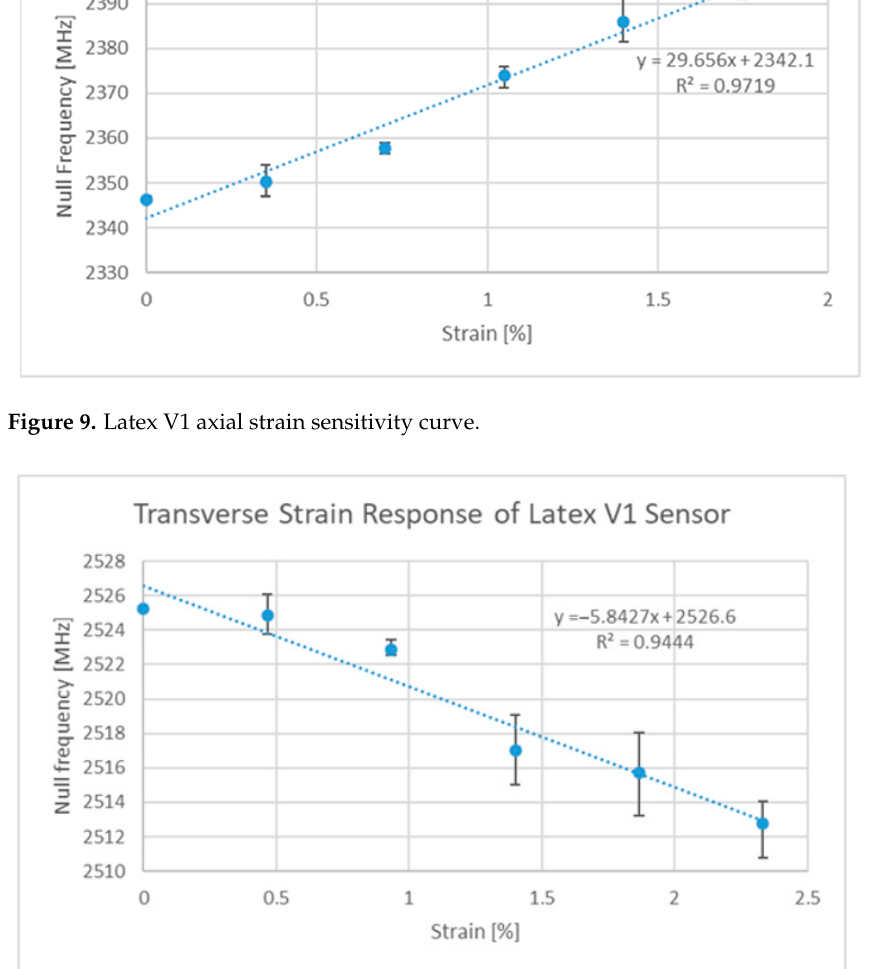
Figure 10. Latex V1 transverse strain cross-sensitivity curve.